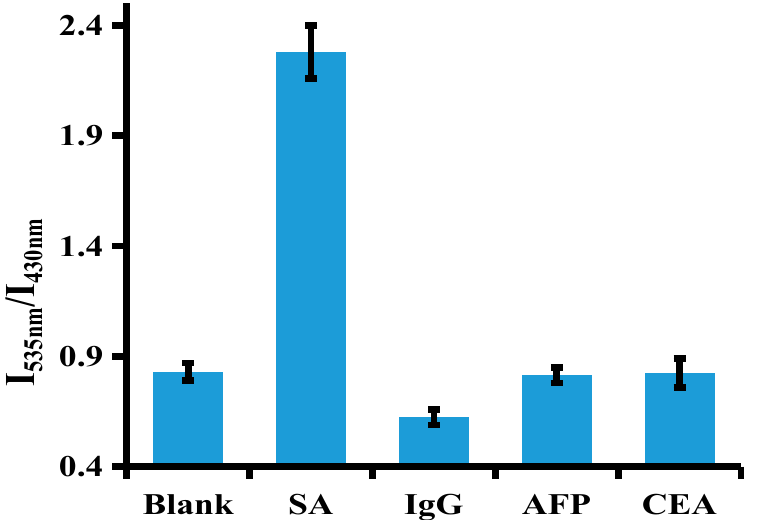
Figure 4. Fluorescence intensity in the presence of SA, IgG, AFP, and CEA. Error bars were estimated from three replicate measurements.